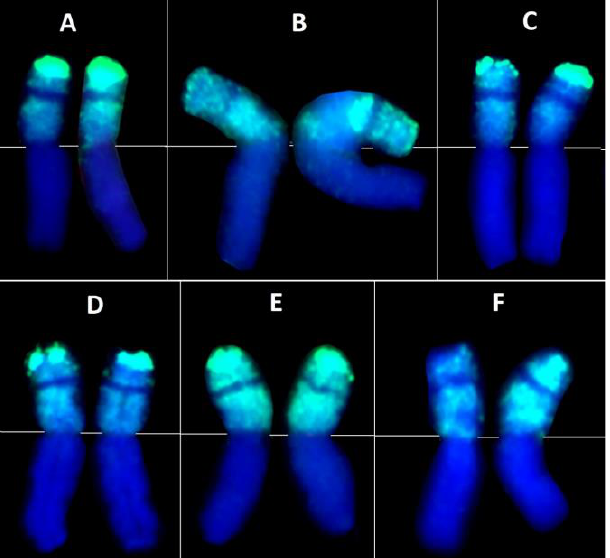
Figure 4. Centric rye-wheat translocated chromosomes revealed using genomic in situ hybridization in winter bread wheat cultivars Tanya ( A ), Avrora ( B ), Vassa ( C ), Polovchanka ( D ), Knyazhna ( E ), and line 2318h9-4-28 ( F ). Green signals indicate rye